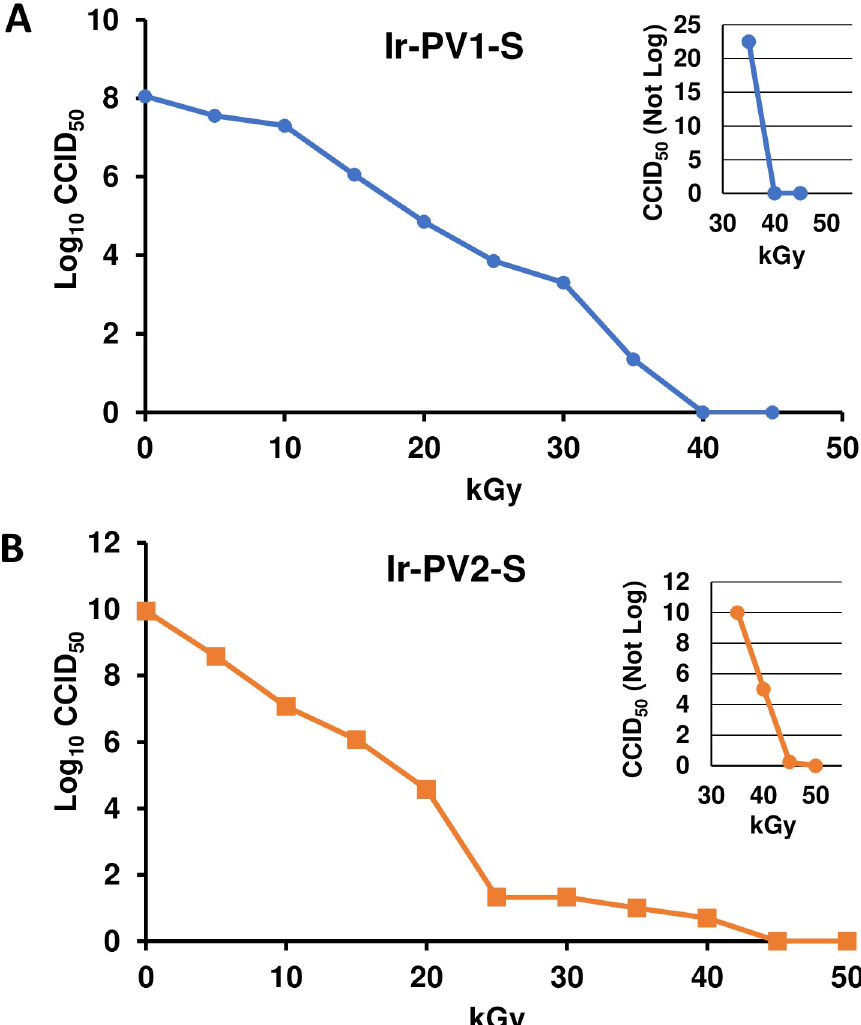
Fig 1. Reduction in infectivity of gamma-irradiated PV. A ) PV1-S and B ) PV2-S samples combined with the MDP complex were exposed to increasing doses of gamma radiation and tested for infectivity using a CCID 50 assay. The larger graphs report the Log 10 values, the insets report non-log titers showing no infectivity at 40 and 45 kGy for PV1-S; and 45 and 50 kGy for PV2-S. Data shown are representative of over five independent experiments. Ir-PV1-S and Ir-PV2-S, gamma-irradiated